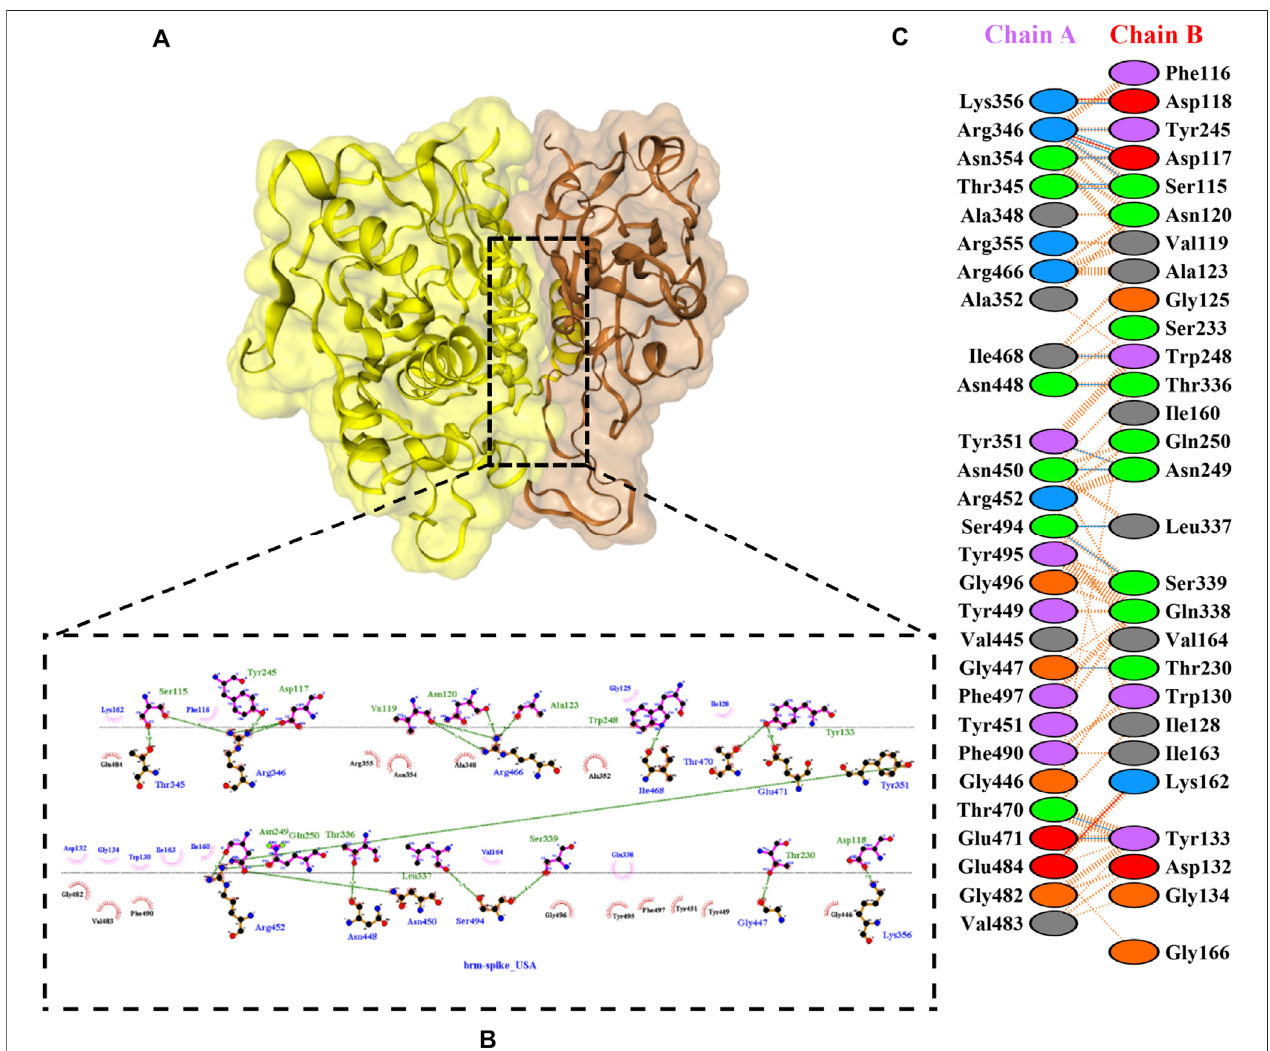
FIGURE 8 | Docking representation of the United States variant and bromelain complex. (A) the binding interface of the complex, (B) the binding interaction betweenthe aminoacids, and (C) interaction representation including hydrogen, saltbridges,and nonbondedinteractions.ChainAisRBD United States and chainBis